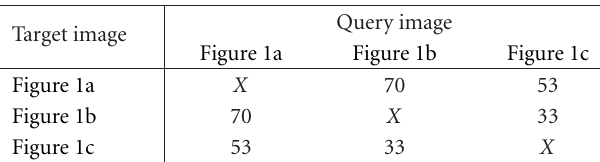
Table 2: Percentages of pixels with the same spatial coordinates whose rank measures within the green target and query images of Figure 1 are the closest ( L =